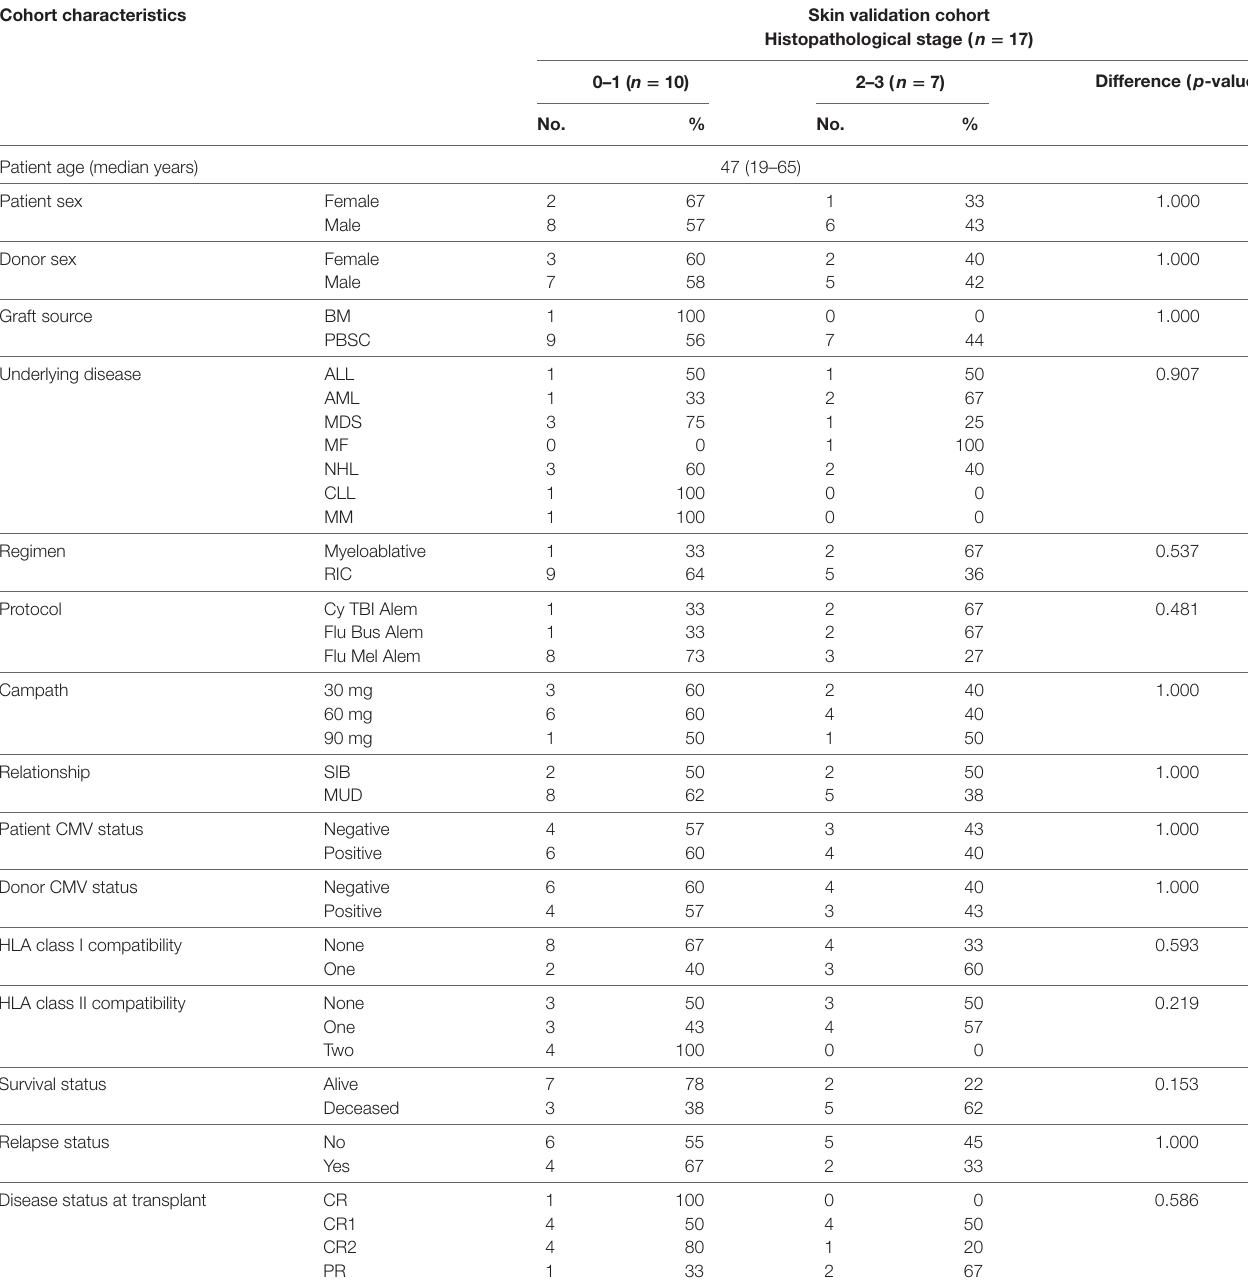
Table 2 | Patient characteristics for the skin validation